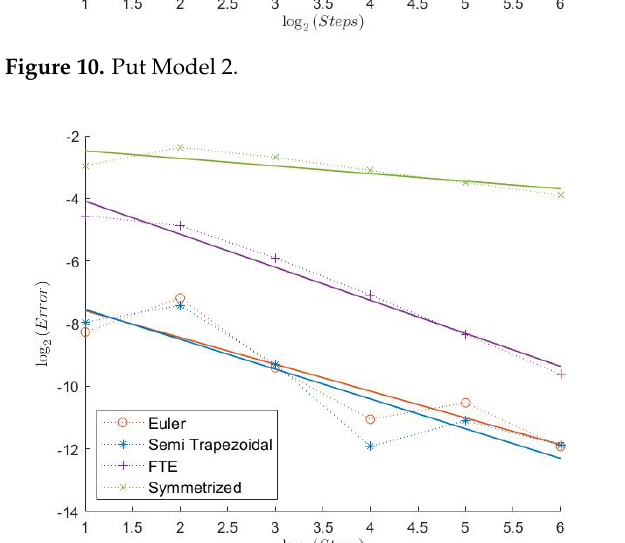
Figure 10. Put Model 2.